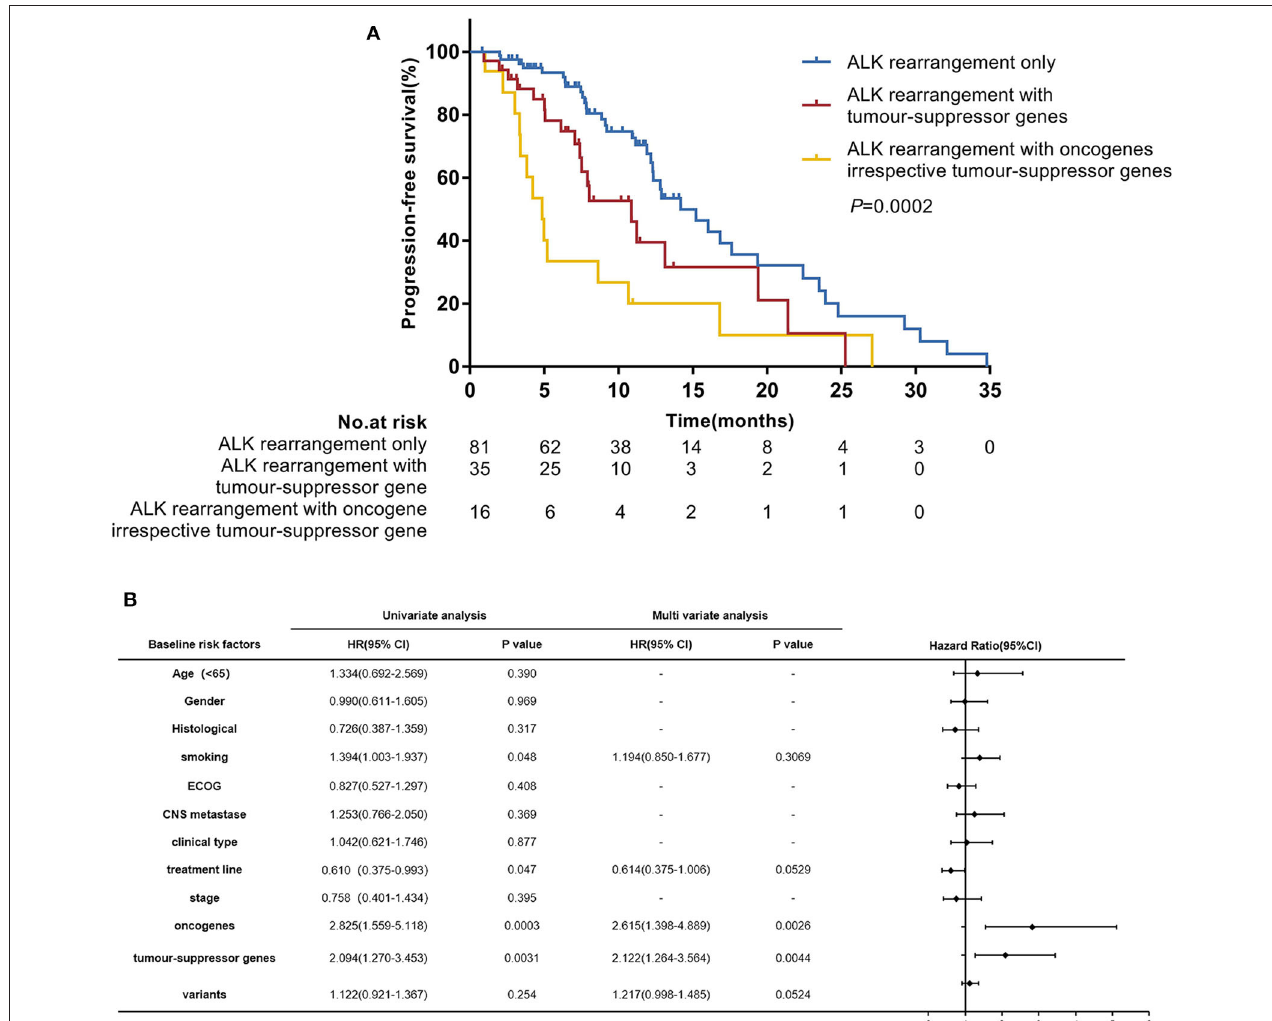
FIGURE 3 | (A) Progression-free survival (PFS) according to concomitant mutations. (B) Hazard ratios (HR) were evaluated by Cox regression. CI, confidence interval; ECOG, Eastern Cooperative Oncology Group performance